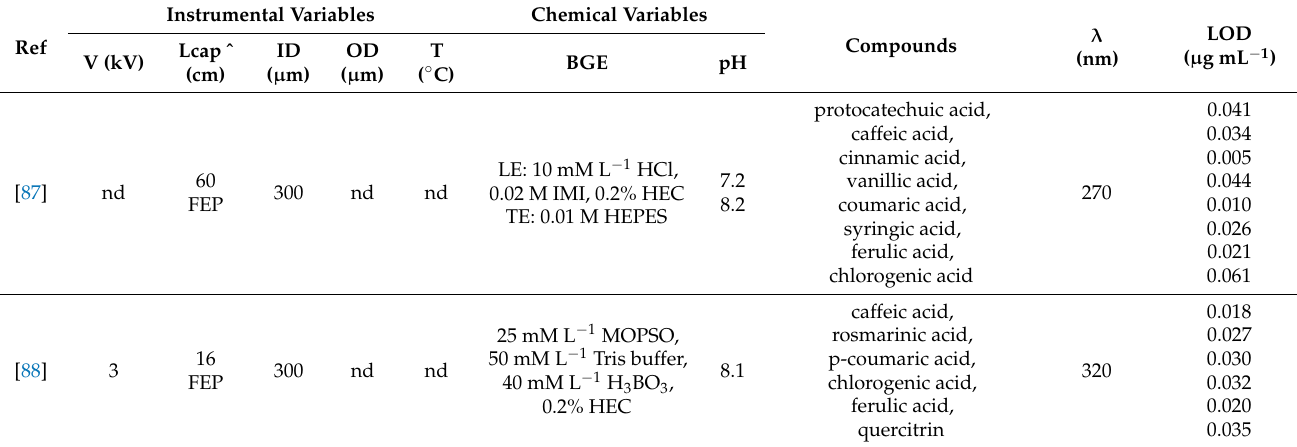
Table 6. Process of separation of analytes with application capillary